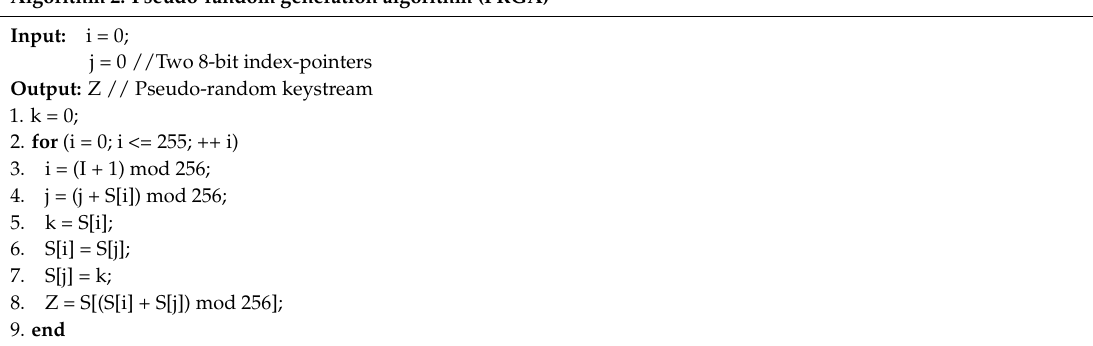
Algorithm 2: Pseudo-random generation algorithm